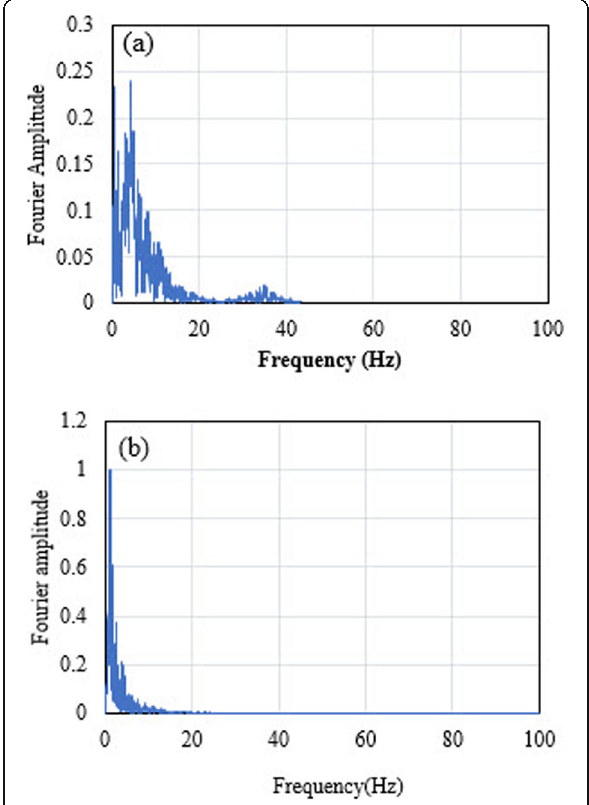
Fig. 1 Fourier spectra of selected input seismic motions: ( a ) Northridge; ( b ) Chi-Chi